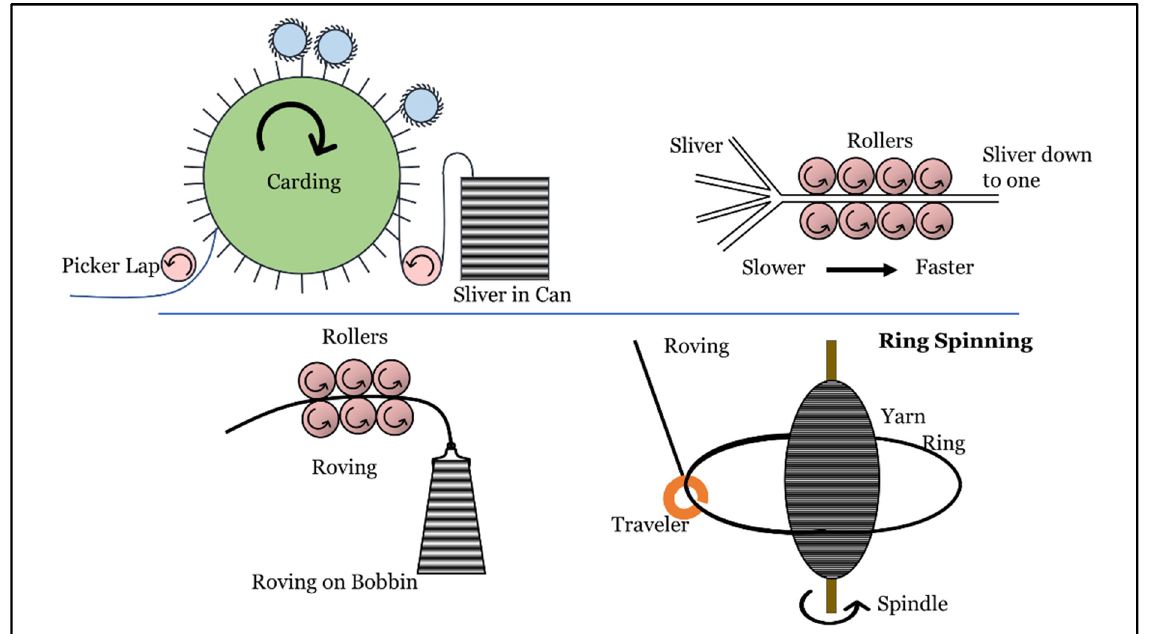
Figure 2. Ring spinning process for collagen yarns. The collagen fibers were provided by the Kaneka Corporation. The fibers were first run through the card and drawer with multiple sets of rollers. The rollers combed the fibers to clean and aligned them before they were gathered to form a sliver in a can. The sliver then passed through a roving frame, where the sliver reduced in diameter to form a roving, which was wound on a bobbin. Finally, the roving bobbins were passed through a ring spinning machine, where their diameters were further reduced via twisting with the help of a traveler and a ring.